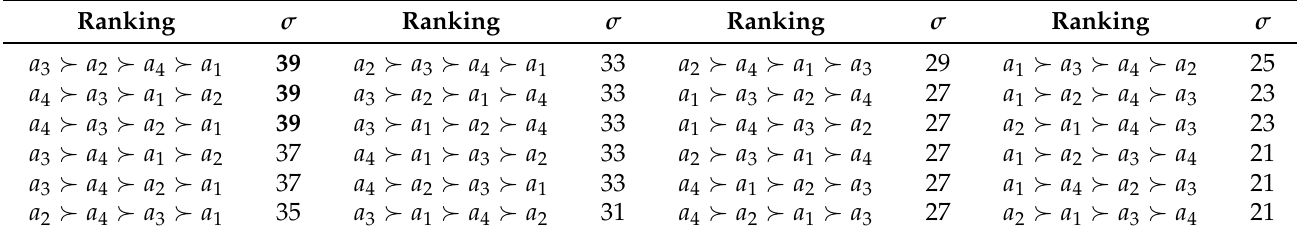
Table 2. Agreement score σ for all the possible rankings according to the Kemeny method for the profile of rankings in Table